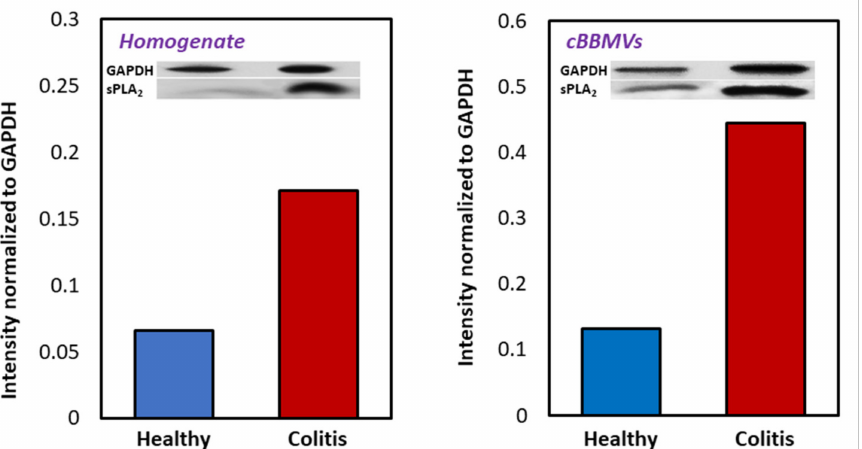
Figure 4. Immunoblotting results for PLA 2 levels in colonic mucosal homogenate ( left ) and cBBMVs ( right ), obtained from a pool of animals in diseased vs. healthy rats (n = 10) normalized to GAPDH. PLA 2 , phospholipase A 2 ; cBBMV, colonic brush border membrane vesicles; GAPDH, glyceraldehyde 3-phosphate